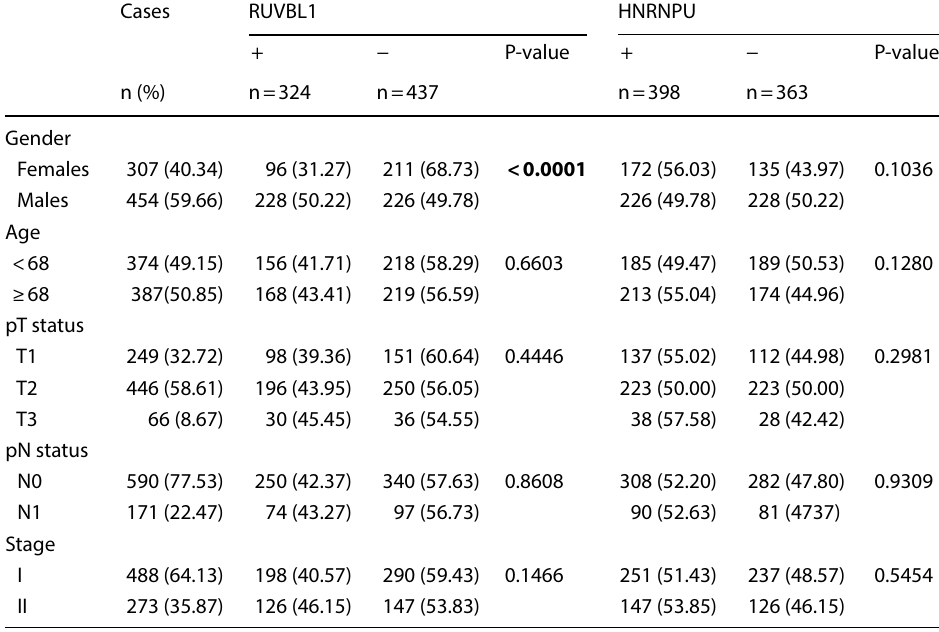
Table 2 Association of RUVBL and HNRNPU, and clinicopathological features in the TCGA cohort of NSCLC patients (n = 761)